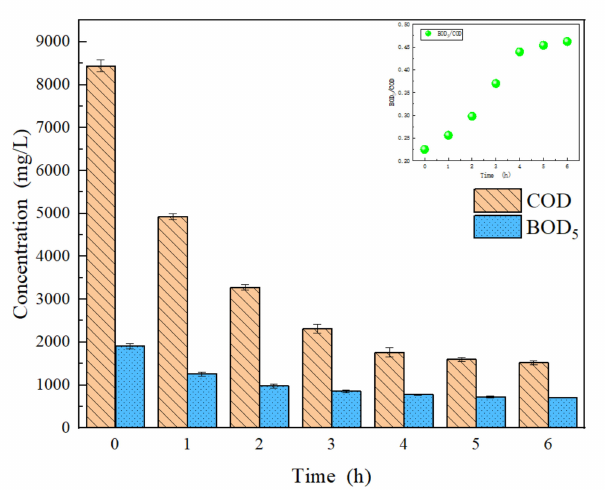
Figure 9. Changes in biodegradability with reaction time. (Initial pH: 3.0; PS/12COD ratio: 1; ZVI dosage: 1.5 g/L; current density: 62.5 mA/cm 2 ; reaction time: 6